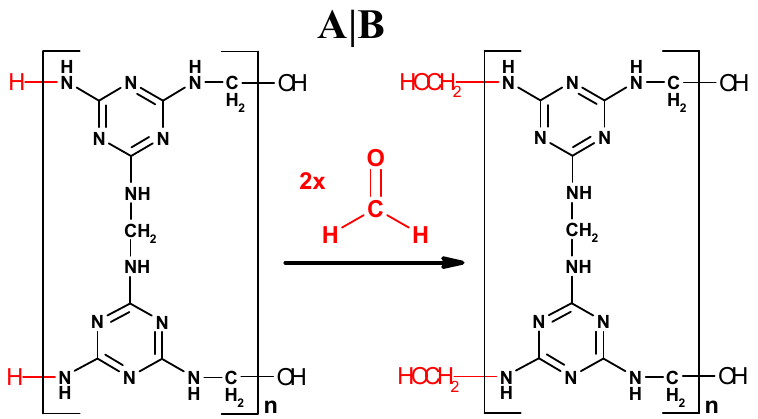
Figure 4. The terminal overreaction of a linear MF resin molecule. ( A ) An linear molecule extended from an ideal polymerized unit C 9 N 12 H 12 , posed from the F:M molar ratio of 1.5:1; and ( B ) the linear molecule with –NH 2 groups further bonded by the excessive formaldehyde.